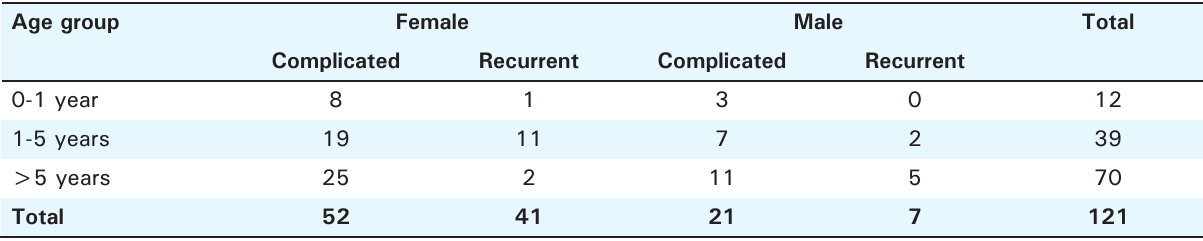
table 1. Demographic data of the study population Age group